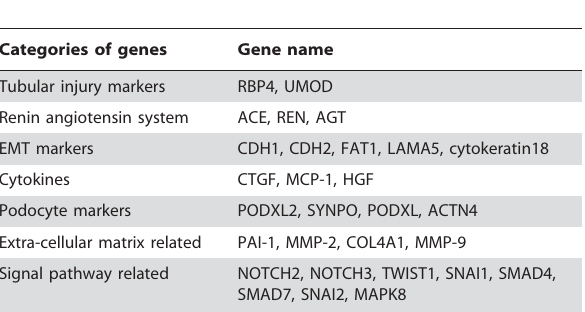
Table 2. Functional categories of 29 up-regulated mRNAs in DN